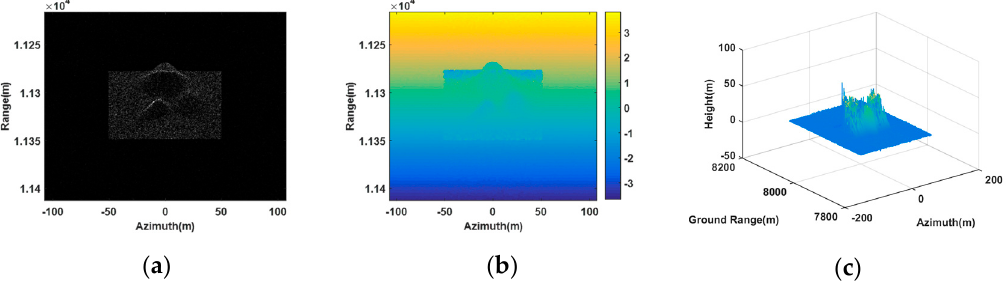
Figure 7. 3D deceptive scene generation simulation based on two transponders. ( a ) SAR image in the antenna A 1 . ( b ) Absolute interferogram after unwrapped. ( c ) DEM of the false